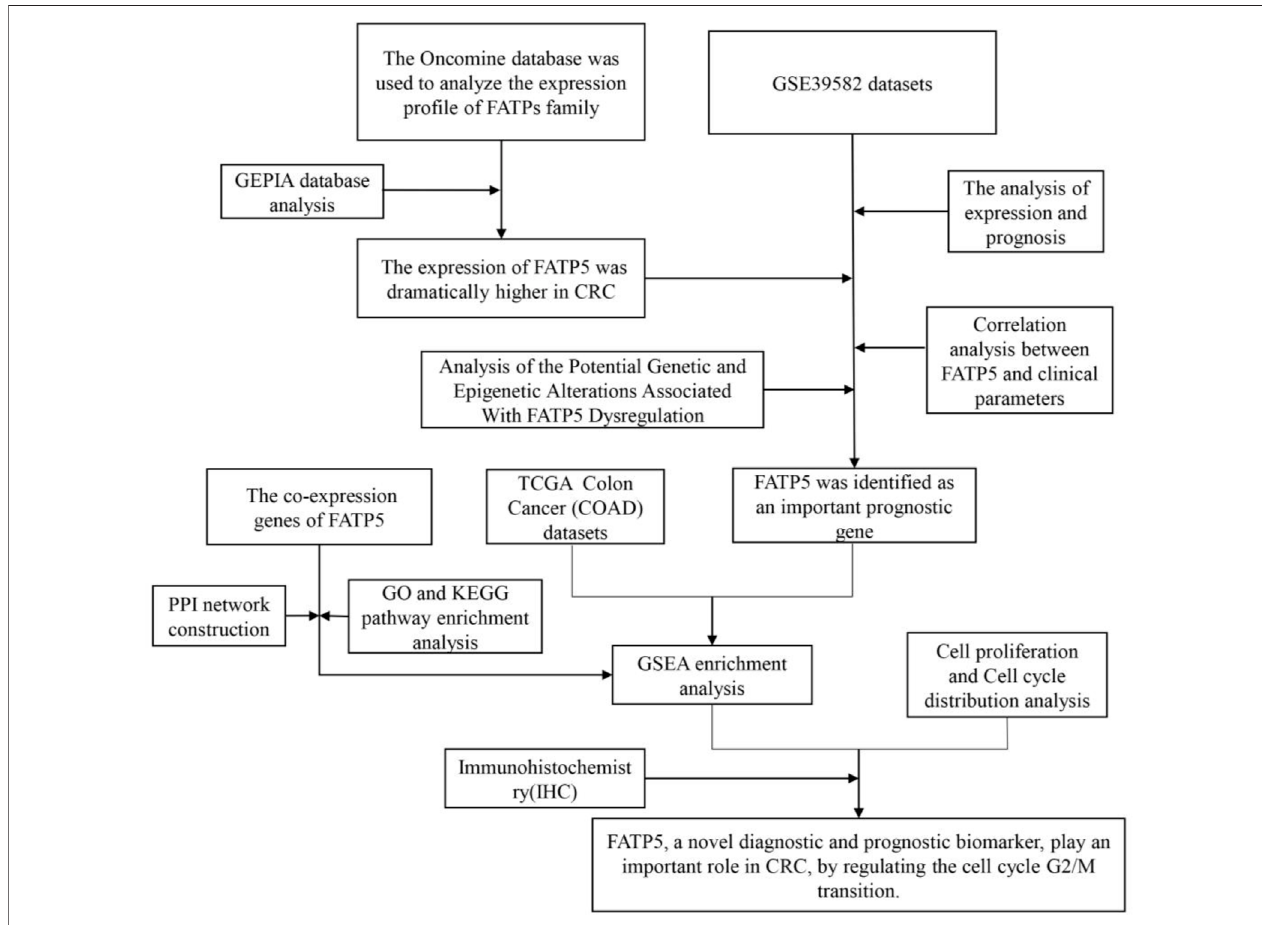
FIGURE 1 | Flow diagram of the